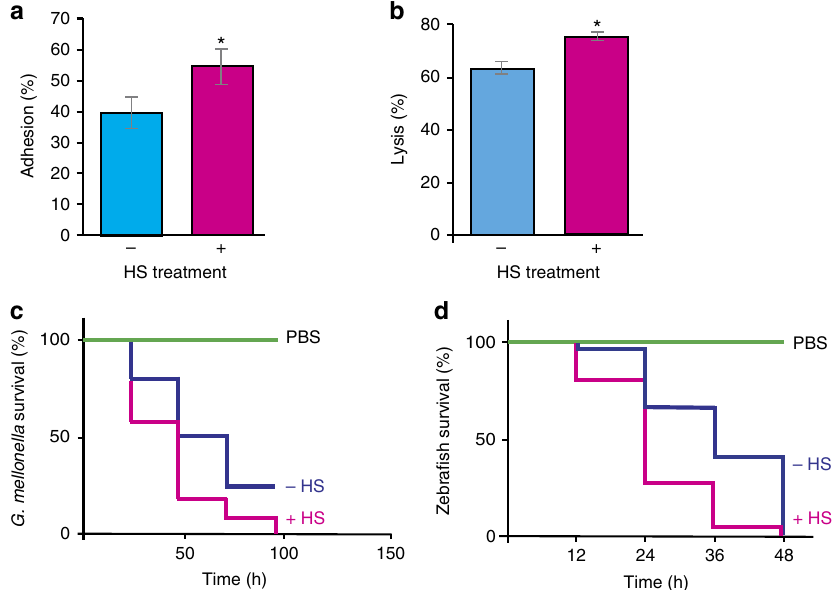
Figure 4 | Heat shock increases pathogenicity traits. ( a ) Increased adhesion of C. albicans wild-type (SN95) cells to TR146 epithelial cells post 30–42 (cid:2) C HS. Results represent percentage of adhered cells from 30 (cid:2) C grown cells (no HS) or 30–42 (cid:2) C heat-shocked cells (HS) compared with control CFUs. Data represent mean values ± s.e.m. from two independent biological replicates. Student t -test, * P o 0.05 compared with wild type. ( b ) Increased cell damage by C. albicans wild-type (SN95) cells post 30–42 (cid:2) C HS to TR146 epithelial cells. Culture medium was assessed for LDH release as a measure of epithelial cell damage of TR146 cells after incubation with C. albicans grown at 30 (cid:2) C (no HS) or subjected to a 15min 30–42 (cid:2) C HS. Data represent mean values ± s.e.m. from two independent biological replicates. Student t-test, * P o 0.05 compared with the wild type. ( c ) HS increases virulence in the G. mellonella model of infection. Twenty larvae per treatment group were injected with 2.5 (cid:3) 10 5 cells of C. albicans wild-type (SN95) cells grown at 30 (cid:2)